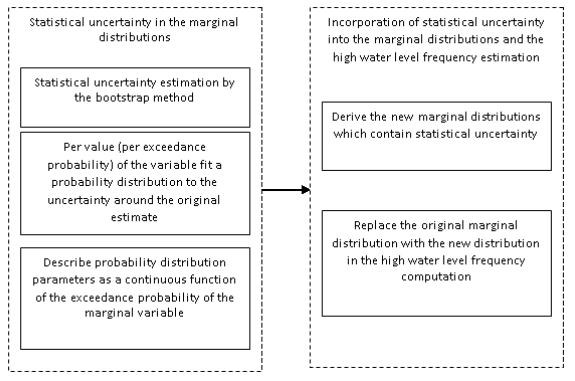
Figure 1. Outline of the method.